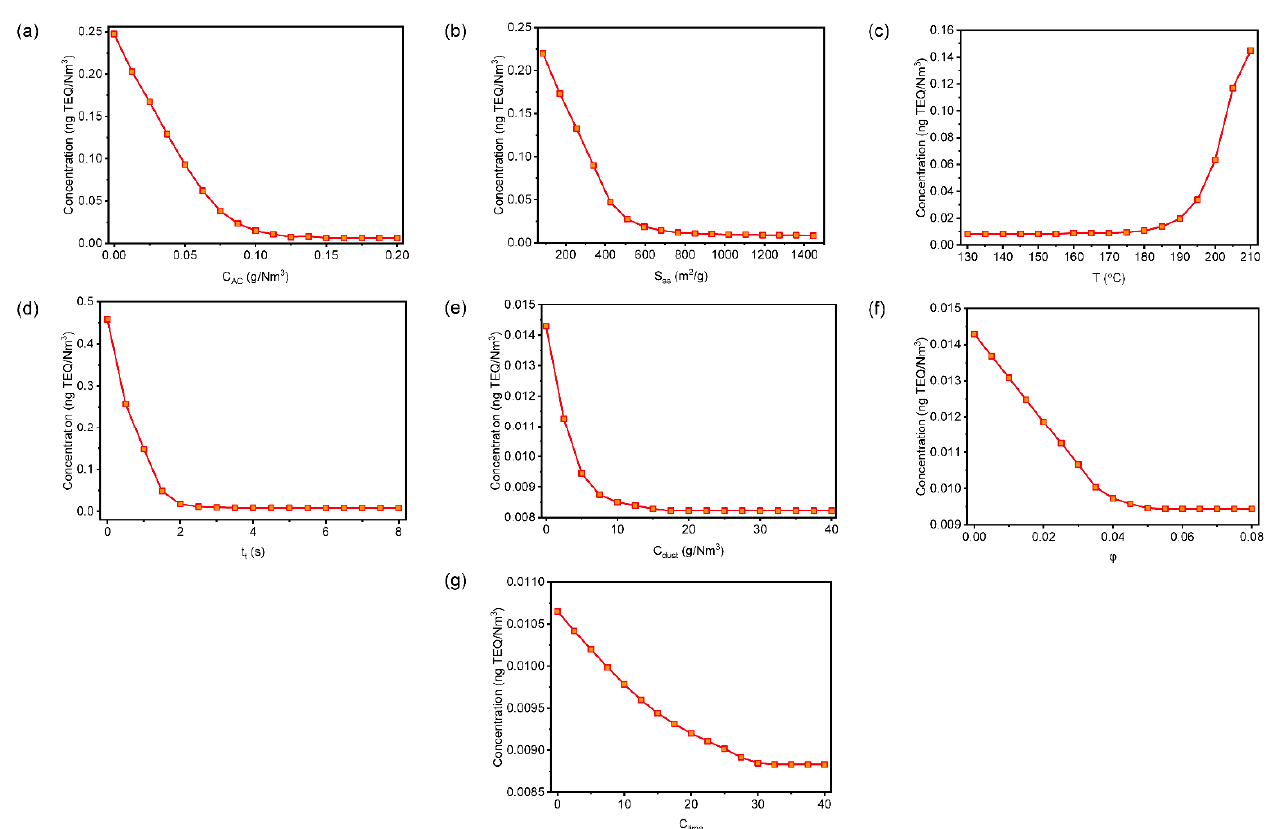
Figure 5. E ff ect of operating parameters of ACI+BF system on the fi nal PCDD/F emissions when Figure 5. Effect of operating parameters of ACI+BF system on the final PCDD/F emissions when final fi nal O 2 concentration is 9.75%: ( a ) AC concentration, ( b ) speci fi c surface area (BET) of AC, ( c ) oper- O 2 concentration is 9.75%: ( a ) AC concentration, ( b ) specific surface area (BET) of AC, ( c ) operating ating temperature, ( d ) contatct time, ( e ) fl y ash concentration, ( f ) residence carbon conentration if temperature, ( d ) contatct time, ( e ) fly ash concentration, ( f ) residence carbon conentration if fly ash, fl y ash, and ( g ) lime concentration. and ( g ) lime concentration.